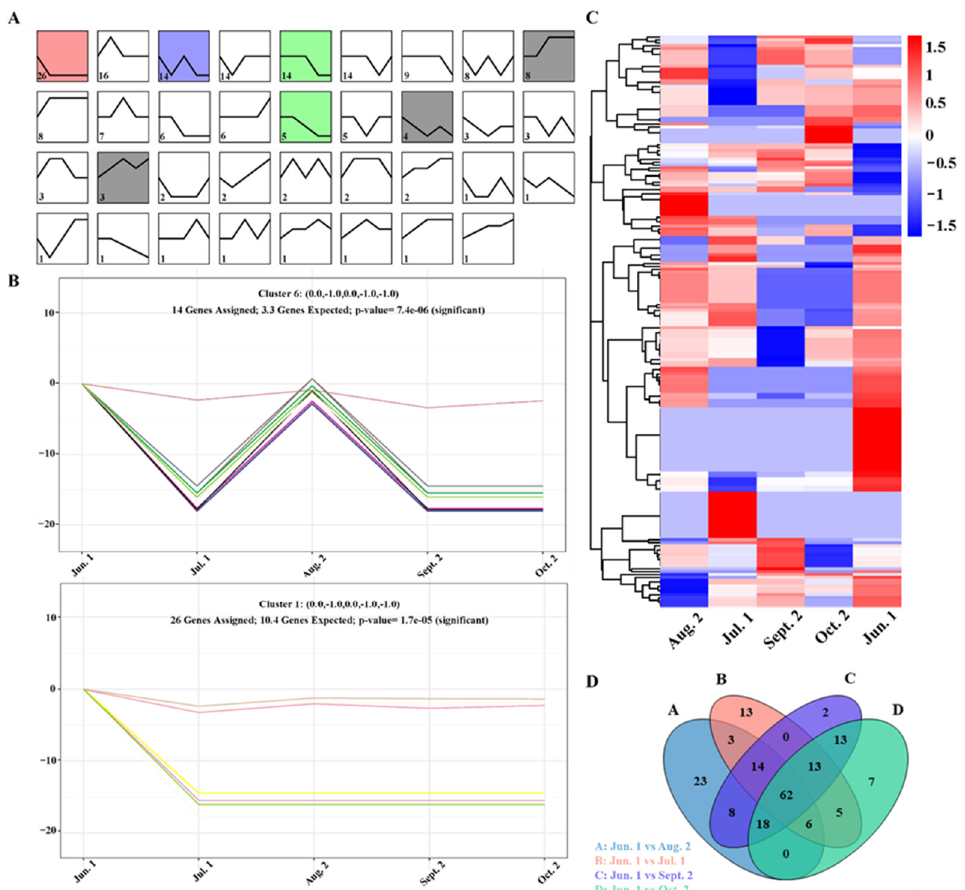
Figure 3. Expressed analysis of miRNAs during seed maturation in T. tuan . ( A ) Analysis of miRNAs expression patterns using the Short Time-series Expression Miner (v 1.1, STEM) program. The trend block with color is the trend of significant enrichment, and the different colors are set by the software to distinguish different trends, which have no special significance; the trend block without color is the trend of non-significant enrichment. ( B ) Expression patterns of known miRNAs and novel miRNAs. ( C ) Heat map of expressed known miRNAs and novel miRNAs in T. tuan seed at five maturational time stages. ( D ) Venn diagram showing the number of difference miRNA under selection in the four groups. The big circle represents each comparison combination, the sum of the numbers in each big circle represents the total number of difference miRNA of the comparison combination, and the overlapping part of the circle represents the common number of difference miRNA between combinations.